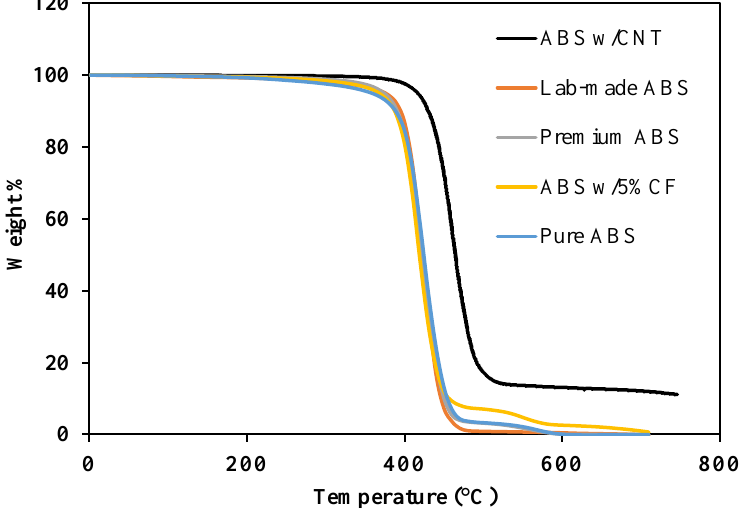
Figure 1. TGA Results of materials conducted in nitrogen gas.